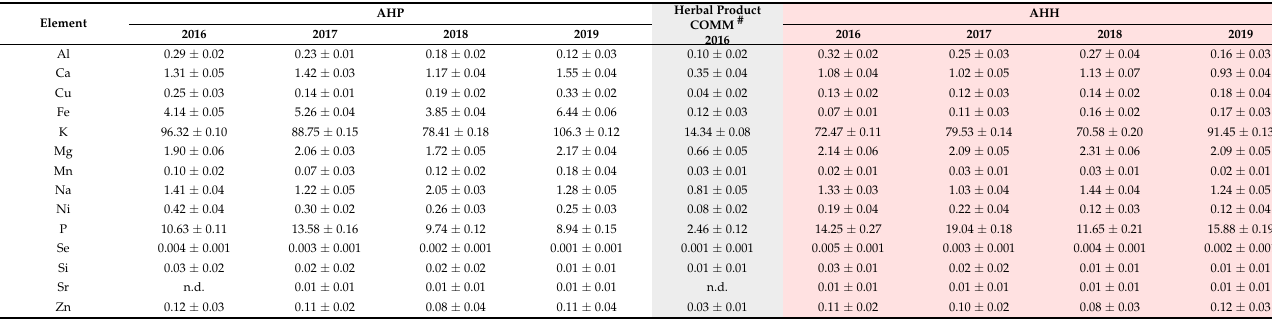
Table 10. Concentrations (*) of some elements (mg/100 g) in horse chestnut crude extracts (mother tincture, 50% hydroalco- holic)